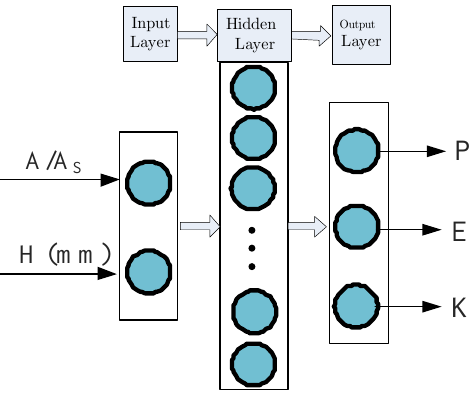
Figure 6. Structure of the proposed radial basis function (RBF)